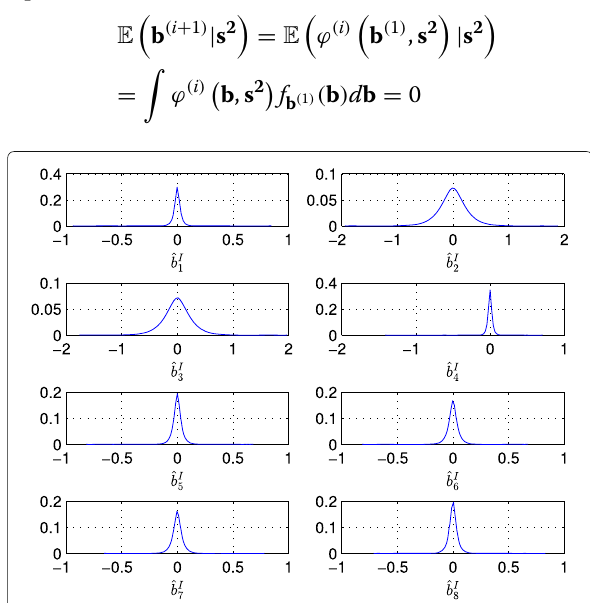
Fig. 8 Histogram of ˆ b I p , p = 1, ... , P , SNR = 10 dB, SIR = 0